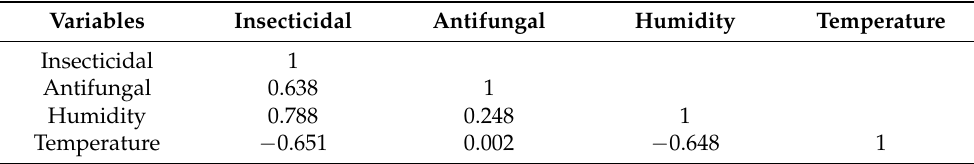
Table 5. Correlation between weekly biocontrol efficacy and weather patterns.